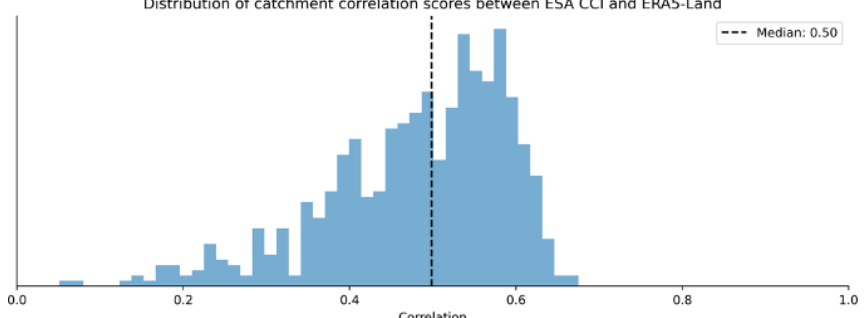
Figure B3. Histogram showing the distribution of correlations between the ESA CCI Soil Moisture and ERA5-Land Soil Moisture products (Soil Water Volume 1 – 0–7cm) for each catchment.